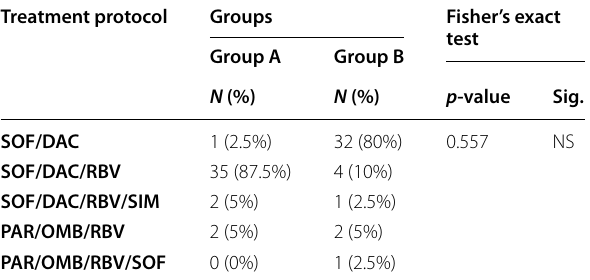
Table 2 Direct‑acting antivirals (DAAs) regimens in the studied groups